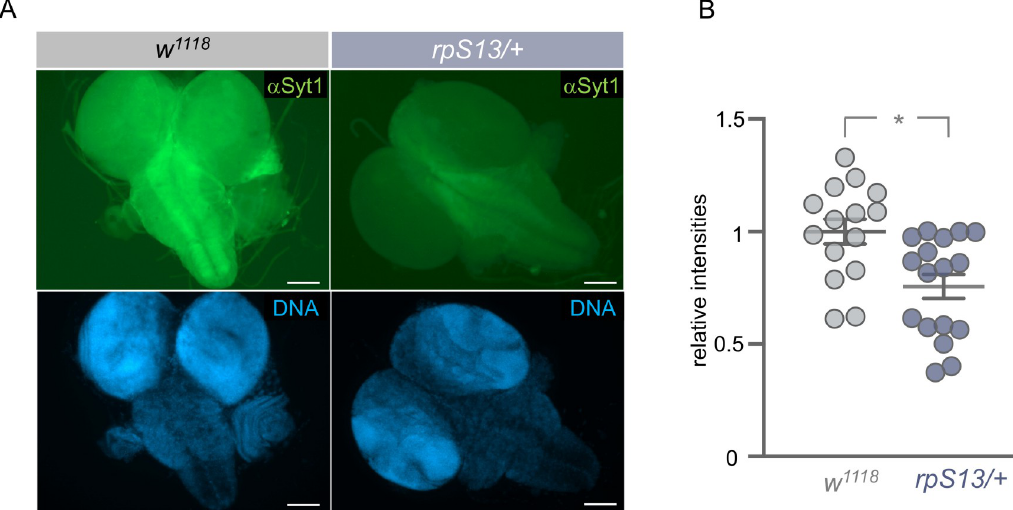
Fig 8. rpS13/+ have reduced brain synaptotagmin (Syt1) levels. (A) Brains of w 1118 and rpS13/+ wandering third-instar larvae stained with anti-Syt1 antibody (green) and Hoechst 33258 (blue). Scale bars, 100 μ m (B) Quantification of relative intensities of anti-Syt1 antibody staining in w 1118 and rpS13/+ brains. Individual data points are plotted, and the bars represent mean +/- SEM. � p > 0.05, Student’s t-test.